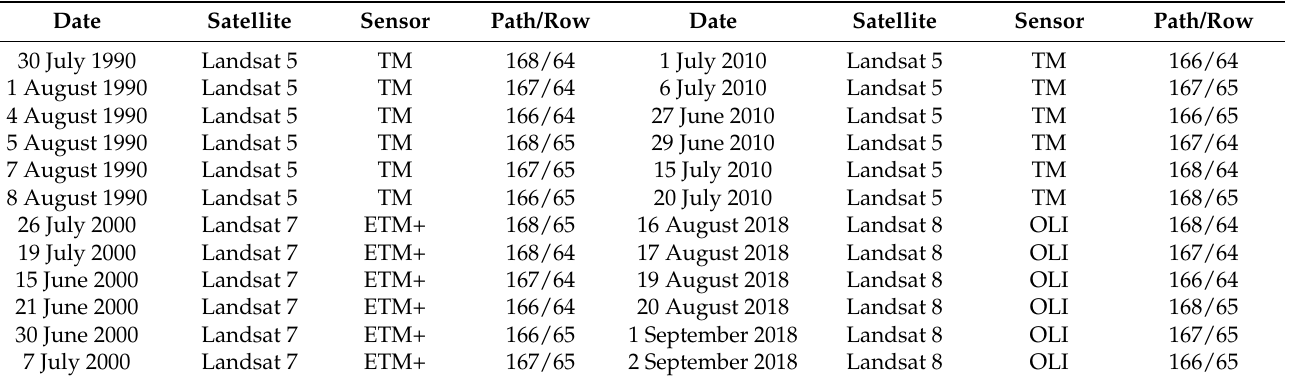
Table 2. The Landsat satellite imageries used in the WRB.